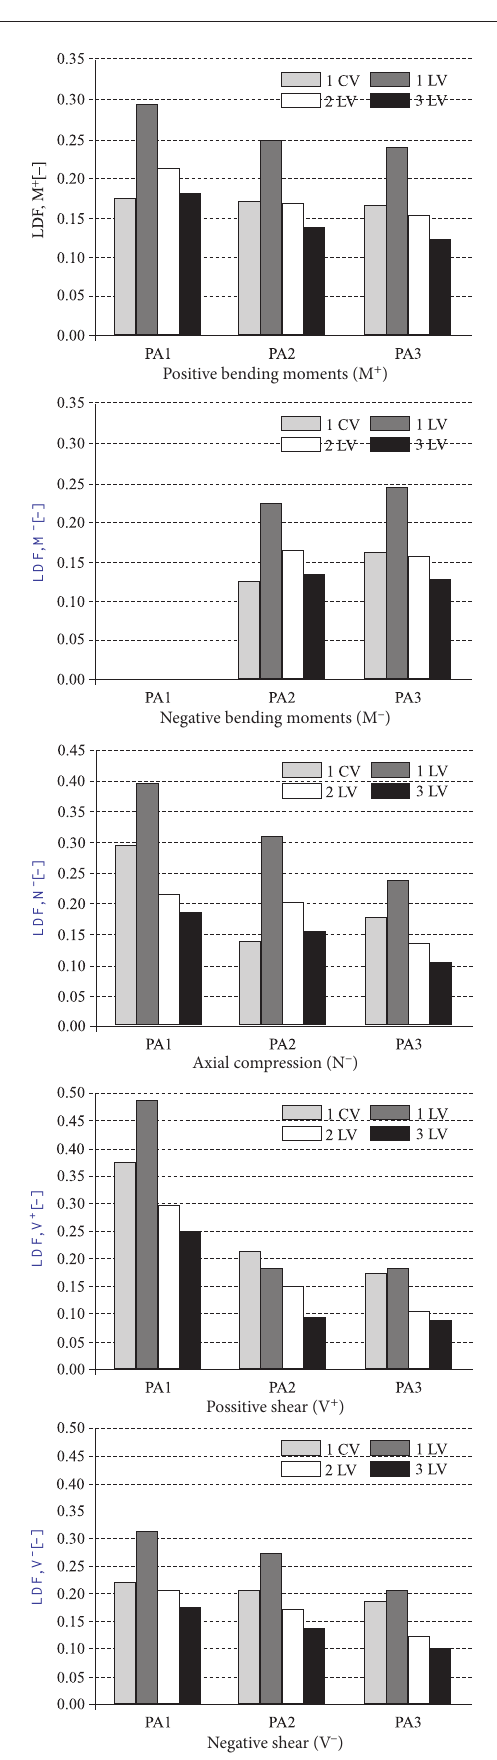
Fig. 8. Maximum load distribution